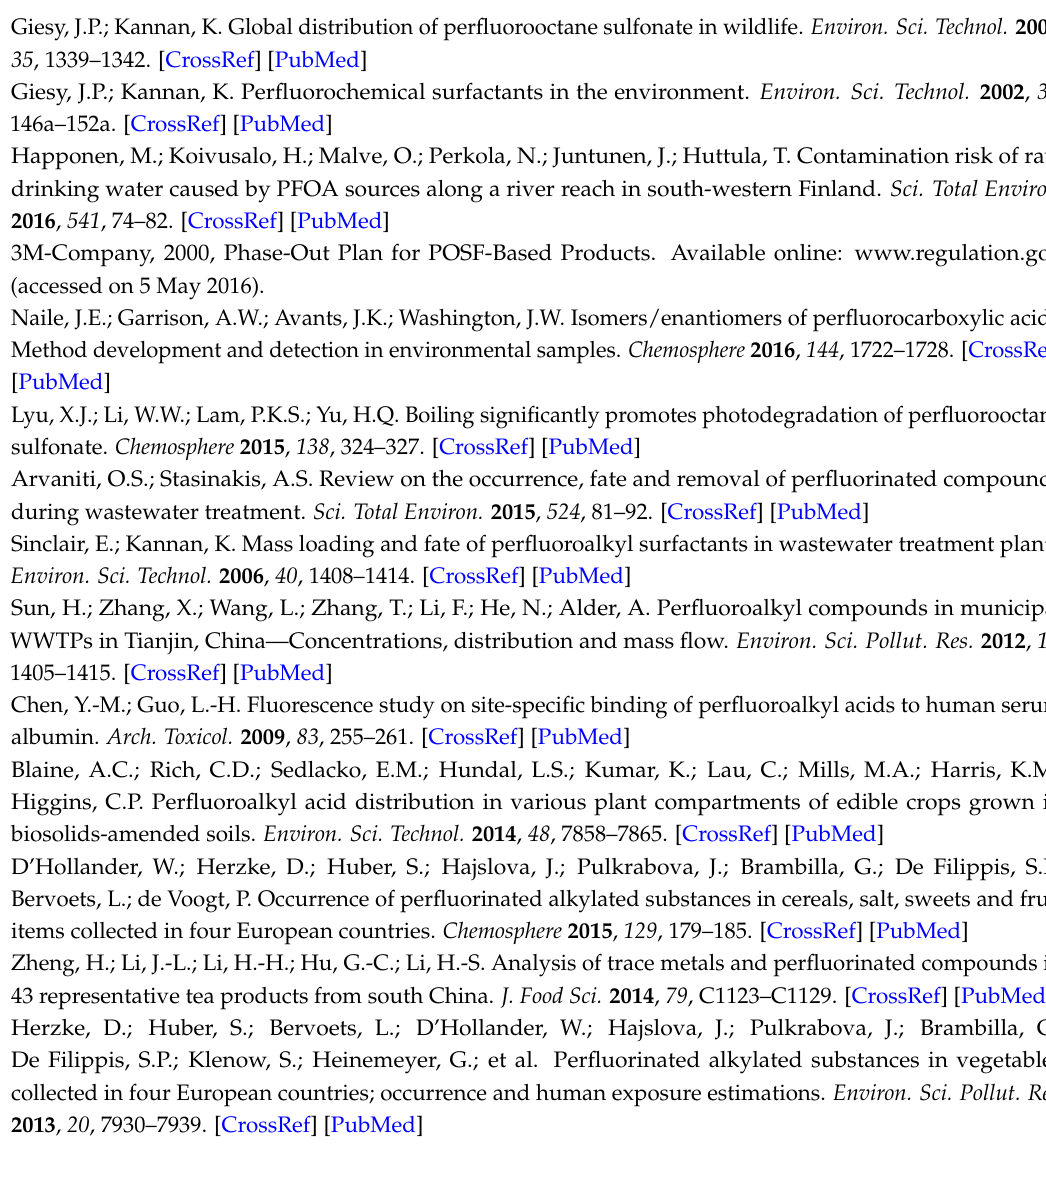
Table S3: Ranges and average of sumPFCA concentrations (ng · g -1 · dw) in vegetable groups of vegetable items collected in